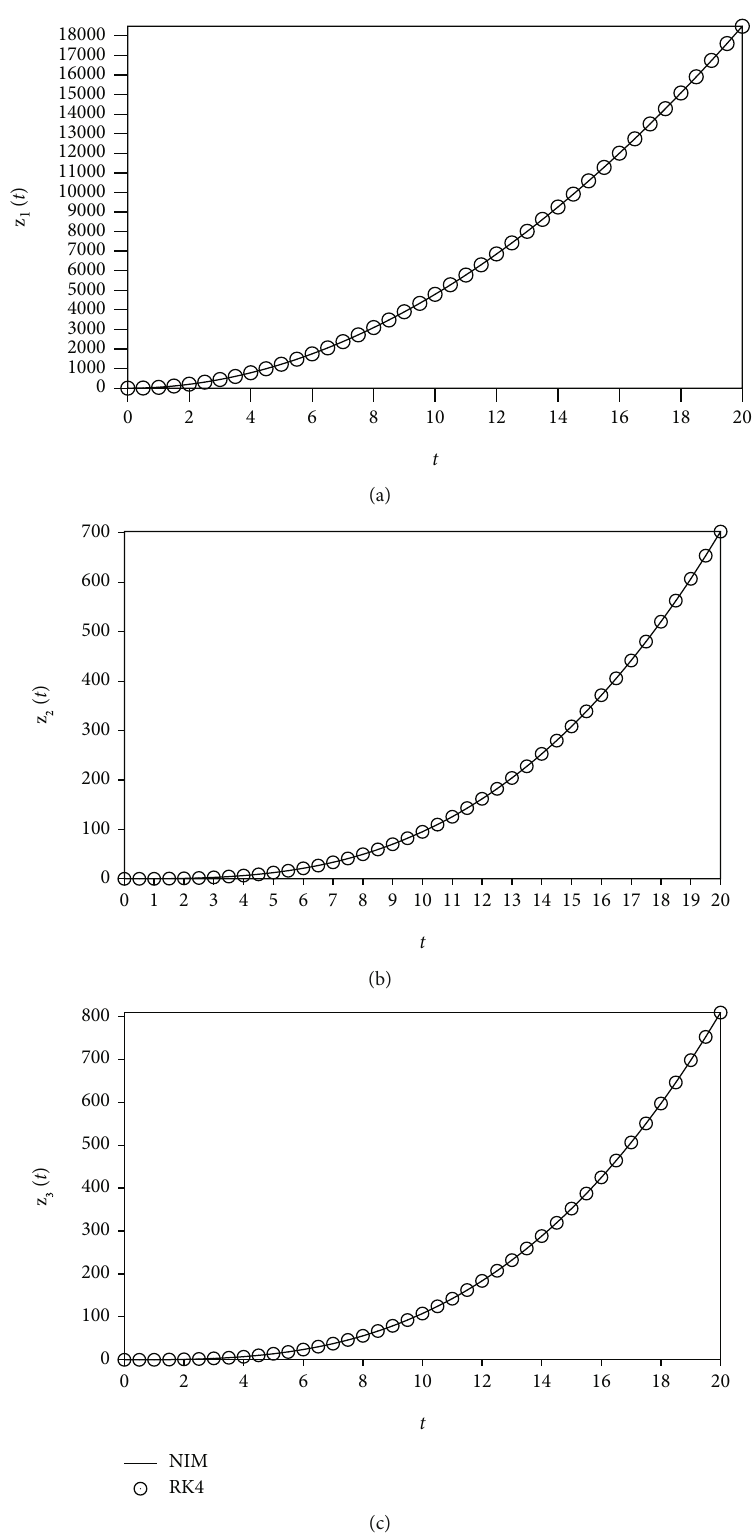
t Þ , (b) z t Þ , and (c) z t Þ in the step input 1 ð 2 ð 3 ð